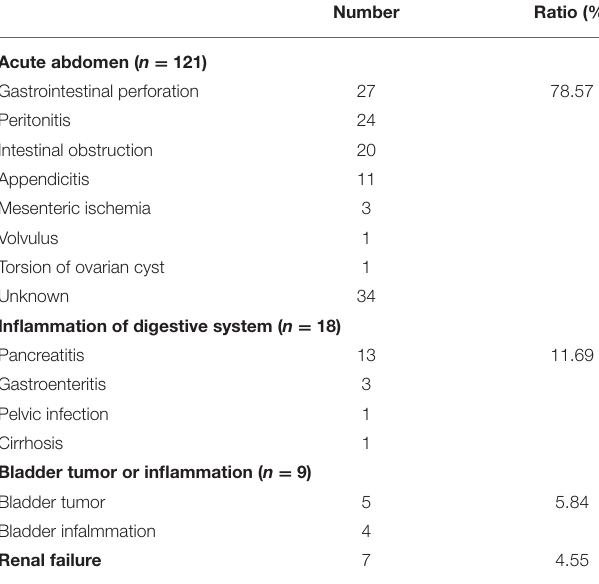
TABLE 3 | Misdiagnosis types of cases